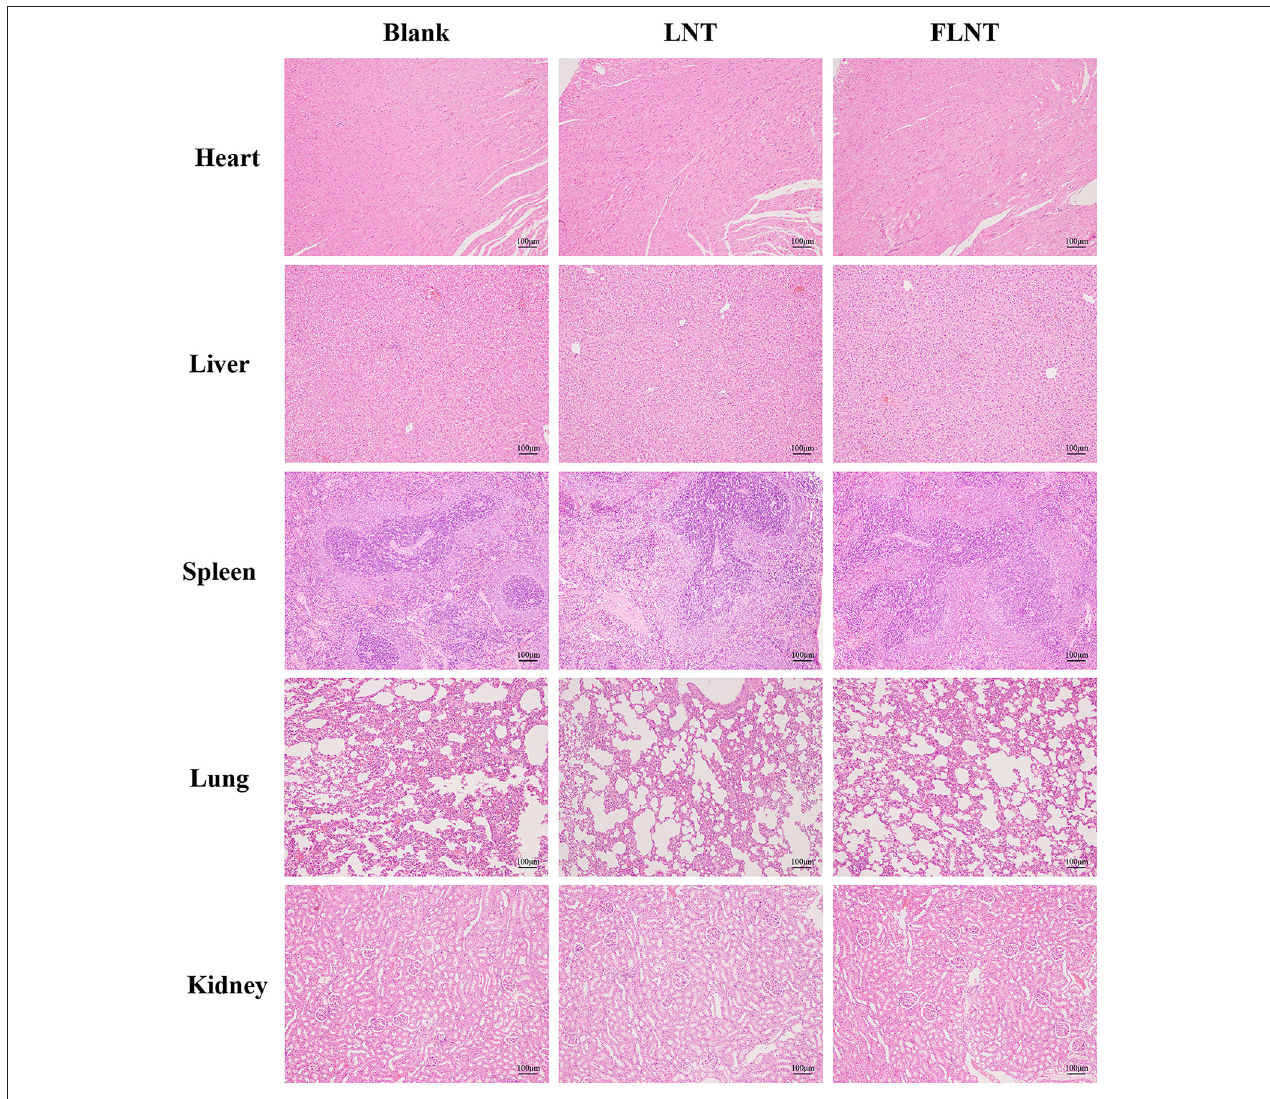
FIGURE 3 | Hematoxylin and eosin staining of organs (bar = 100 µ